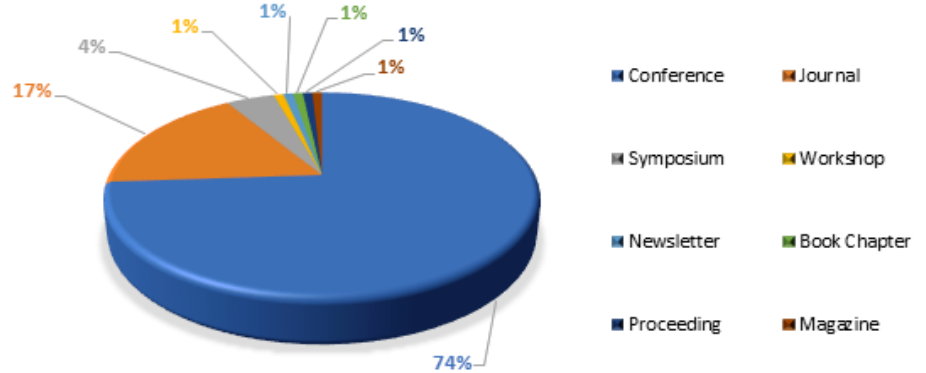
Figure 3. Percentage of selected papers in different publication sources.